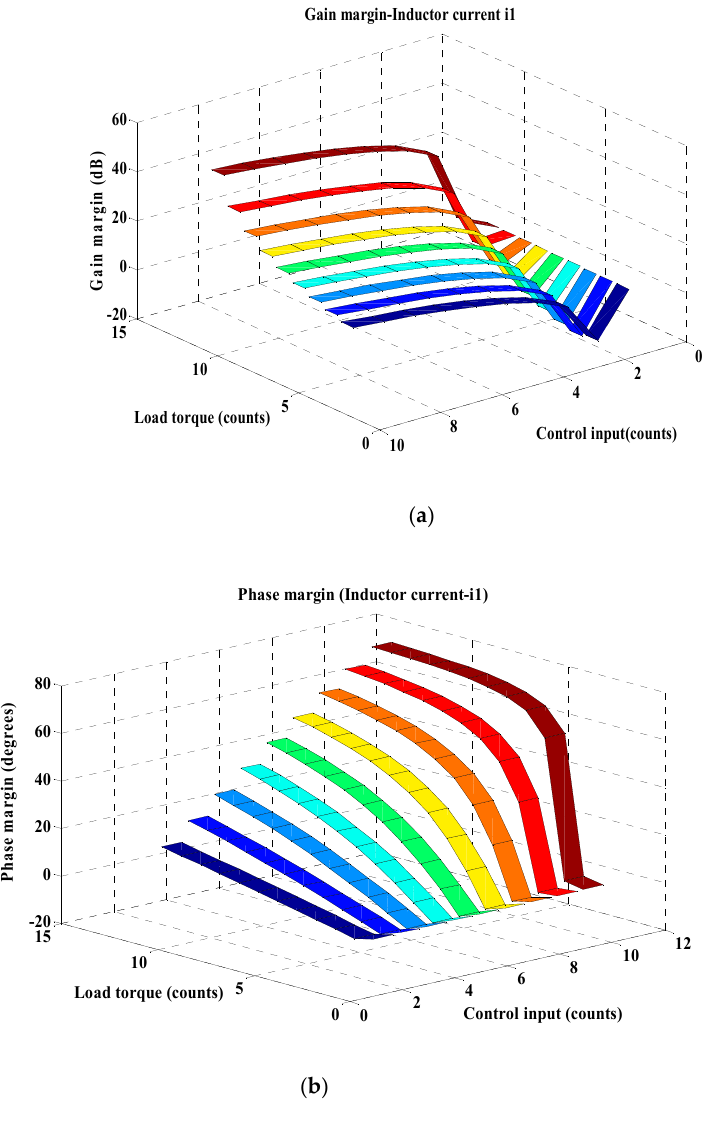
Figure 11. Frequency response of inductor current (i 1 ).( a ) Gain margin; ( b ) Phase margin